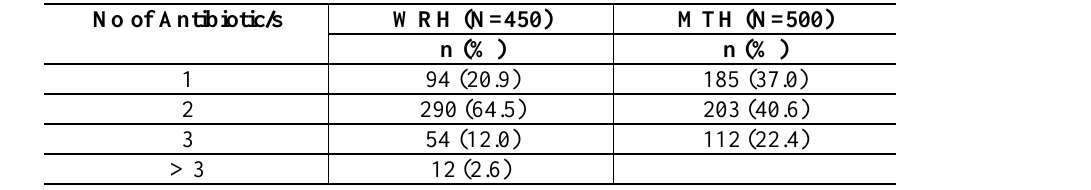
Table VI : Number of antibiotic/s used for